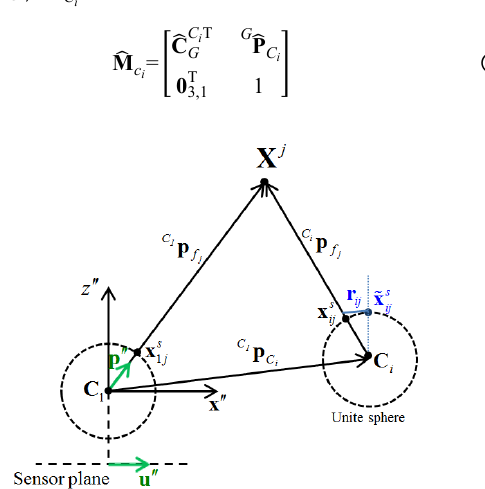
Figure 2. The components of reprojection in a single view-point omnidirectional